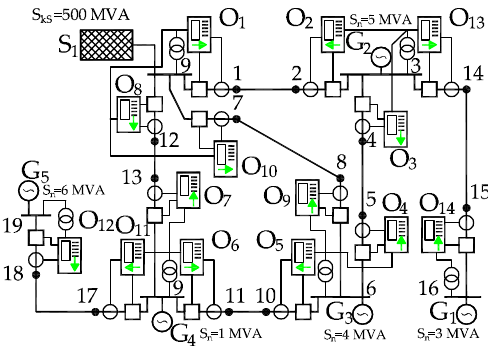
Figure 9. Coordinated IEEE 6-bus power system.